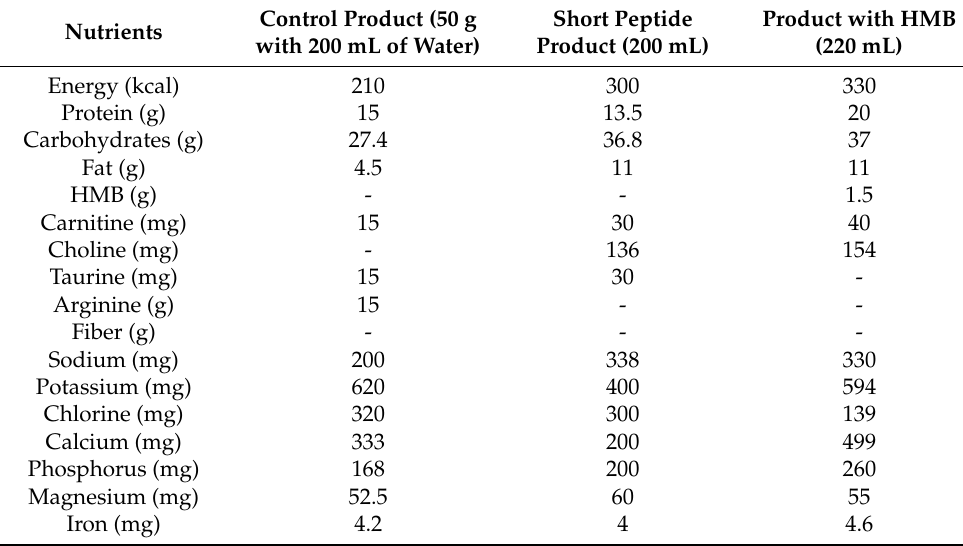
Table 1. Nutritional composition of the products